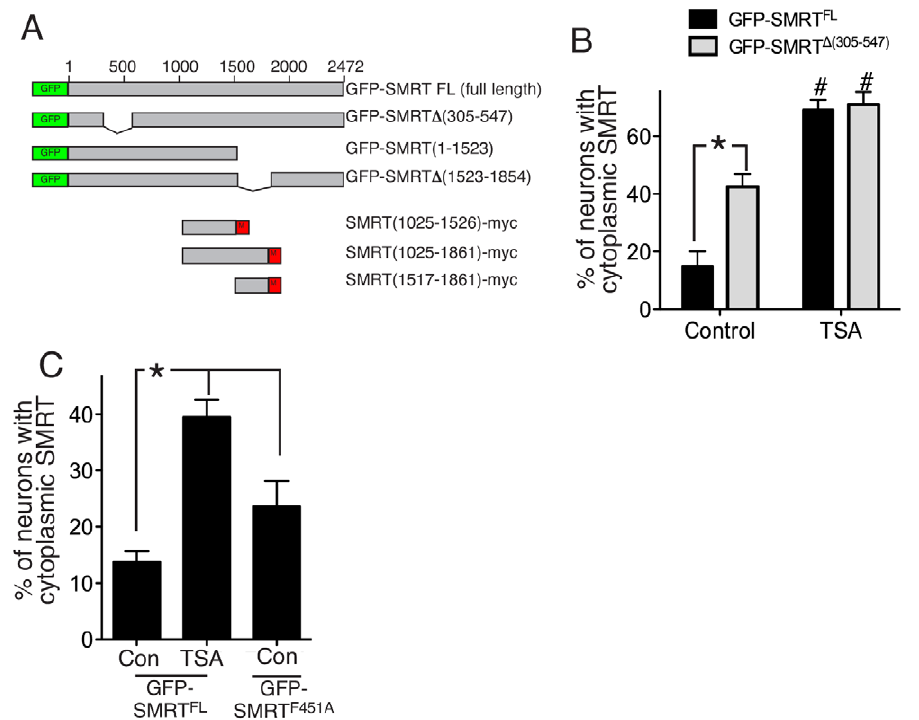
Figure 2. Deletion of SMRT’s HDAC3-activating domain partly mimics and occludes the effect of HDAC inhibition. A) Schematic illustrating the SMRT deletion constructs generated and used in this paper. B) Analysis of the cellular localization of GFP-SMRT FL or GFP-SMRT D (305–547) in transfected neurons untreated or treated with TSA. * p , 0.05 (n=4). # p , 0.05 comparing control and TSA-treated conditions for each SMRT construct. C) Analysis of the cellular location of GFP-SMRT FL compared to the basal localization of GFP-SMRT F451A . * p , 0.05 (n=5).